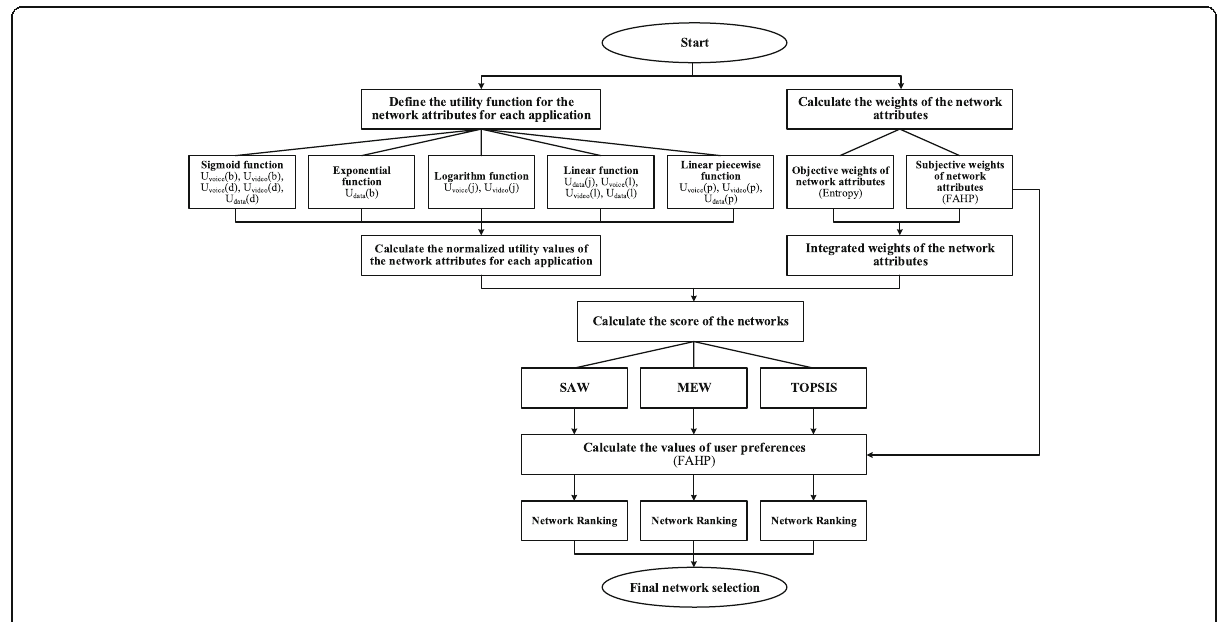
Fig. 1 Flow chart of the proposed network selection